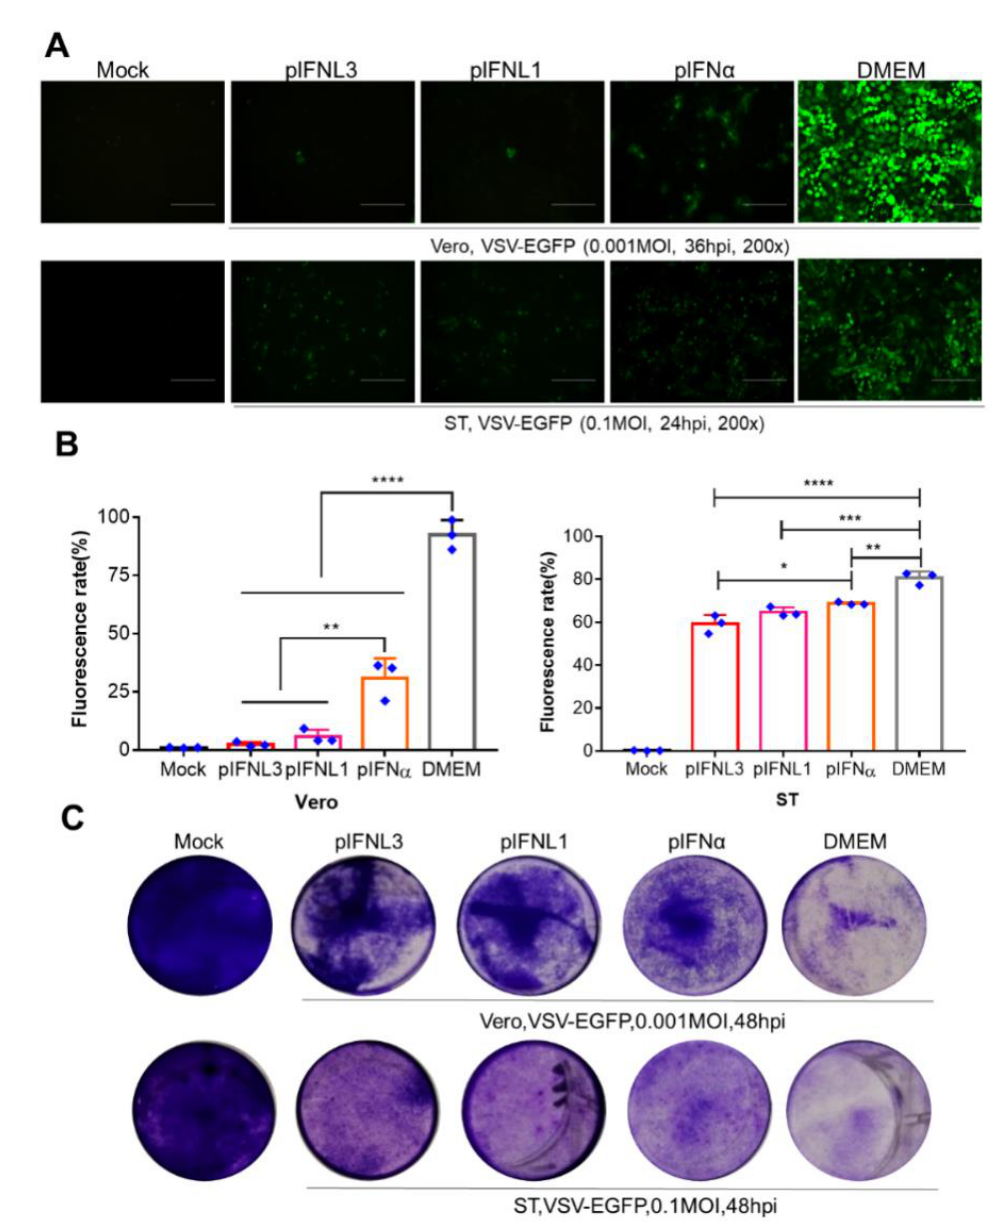
Figure 3. Antiviral activities of pIFNLs against VSV-EGFP in ST and Vero cells; pIFN α served as the control. ( A ) The identified antiviral activities of IFNLs were analyzed by crystal violet after VSV-EGFP infection. Mock means the normal cells without any treatment. The scale bar corresponds to 150 µ m. ( B , C ) Analysis of the antiviral activity of pIFNL1 by fluorescence observation and flow cytometry using 12-well plates after VSV-EGFP infection. *, p < 0.05; **, p < 0.01; ***, p < 0.001; ****, p < 0.0001.